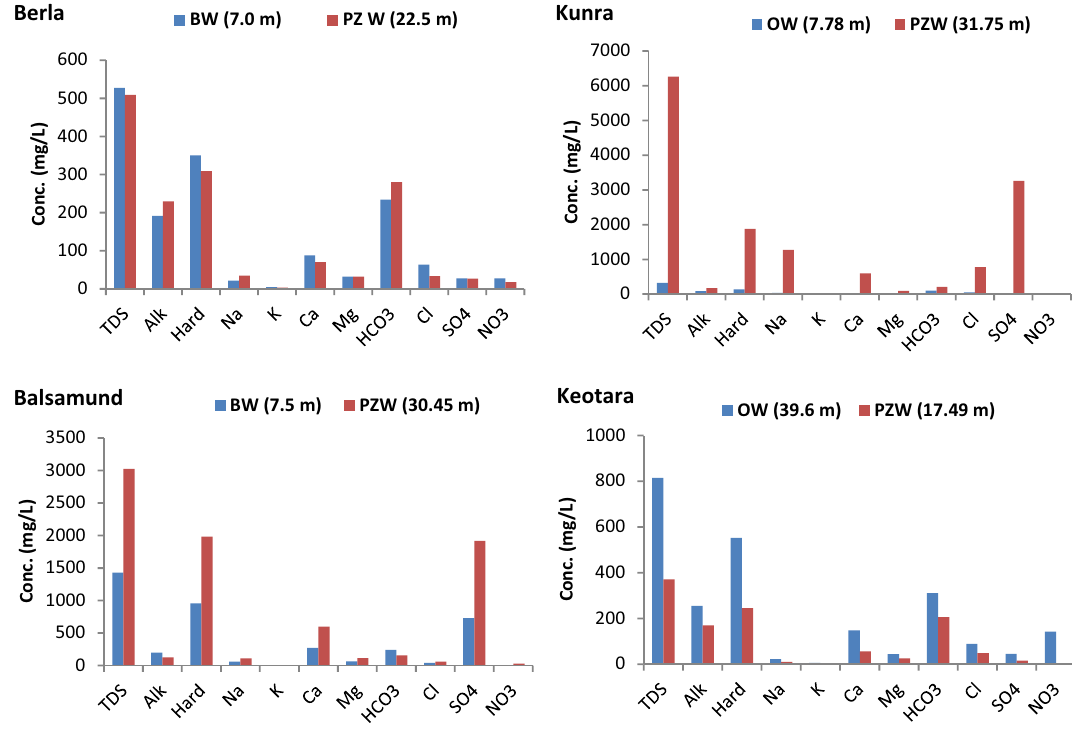
Fig. 8 Water quality at different